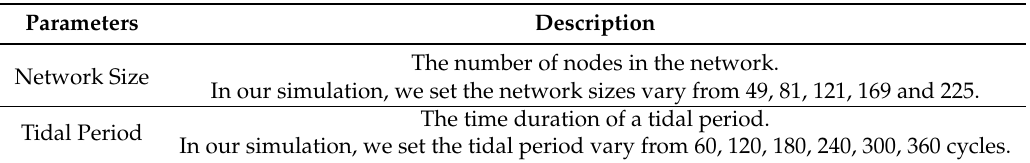
Table 3. The summary of the simulation